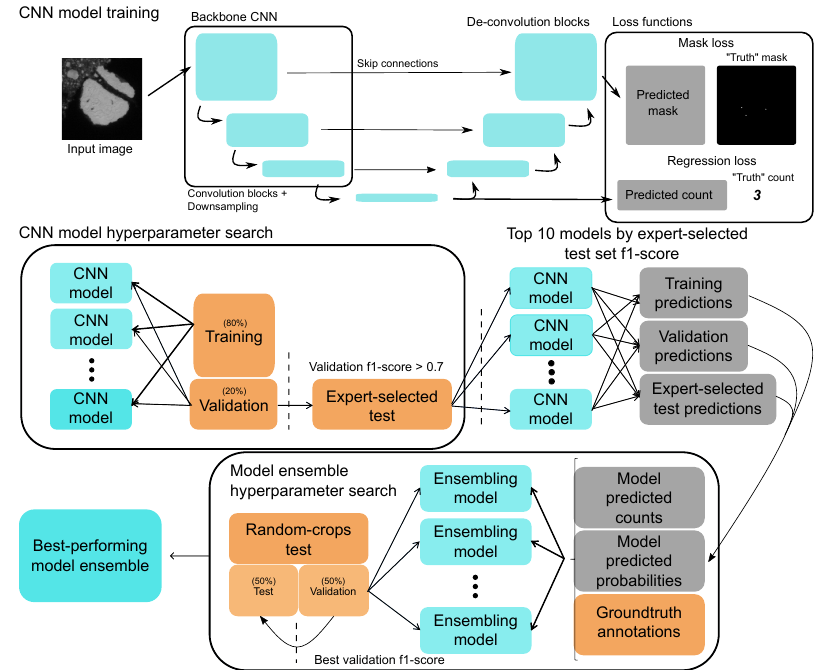
Figure 1. Simplified diagram for SealNet 2.0 showing the training of individual CNN models, model hyperparameter search, and model ensembling. Boxes colored in light-blue denote models, orange boxes denote datasets, and gray boxes denote model output. Thick black lines from datasets to models indicate model training. Dashed vertical lines indicate model selection steps. The best individual CNN models are trained on seal detection, including centroid segmentation and seal count regression, using a random search with training and validation, and the f1-score at the expert-selected test set for model selection. The best ensembling models are selected via Bayesian optimization, using top-10 CNN model predictions for the training set, validation set, and the expert-selected test set as dependent variables for training; true positive vs. false positive as the response variable; and the f1-score at the validation split from the random crops test set as a validation metric. Finally, we use the test portion of the random crops test set to estimate the out-of-sample performance of the best-performing model